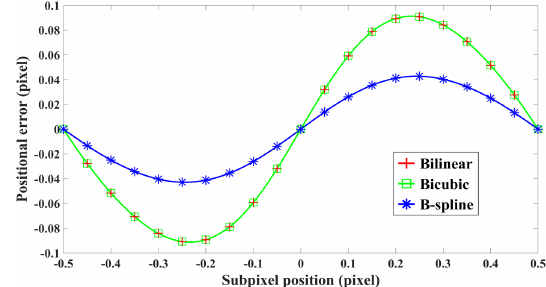
Figure 9. Theoretical positional errors of three interpolators for λ